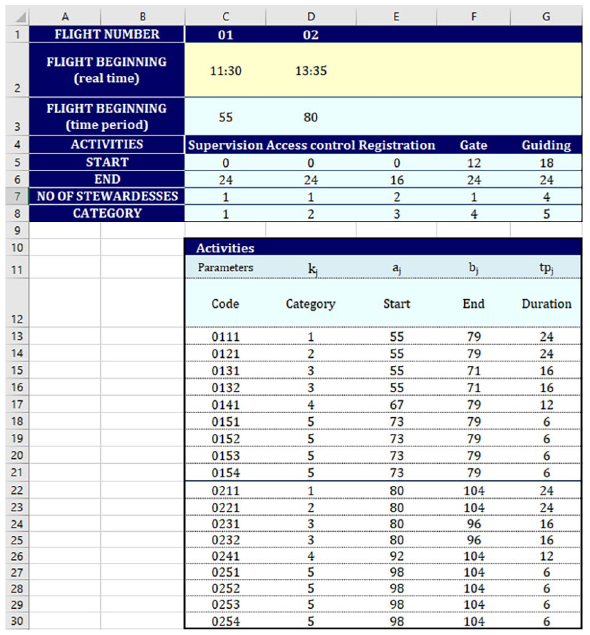
Figure 1. Example of activities arrays including code, category, start, end and